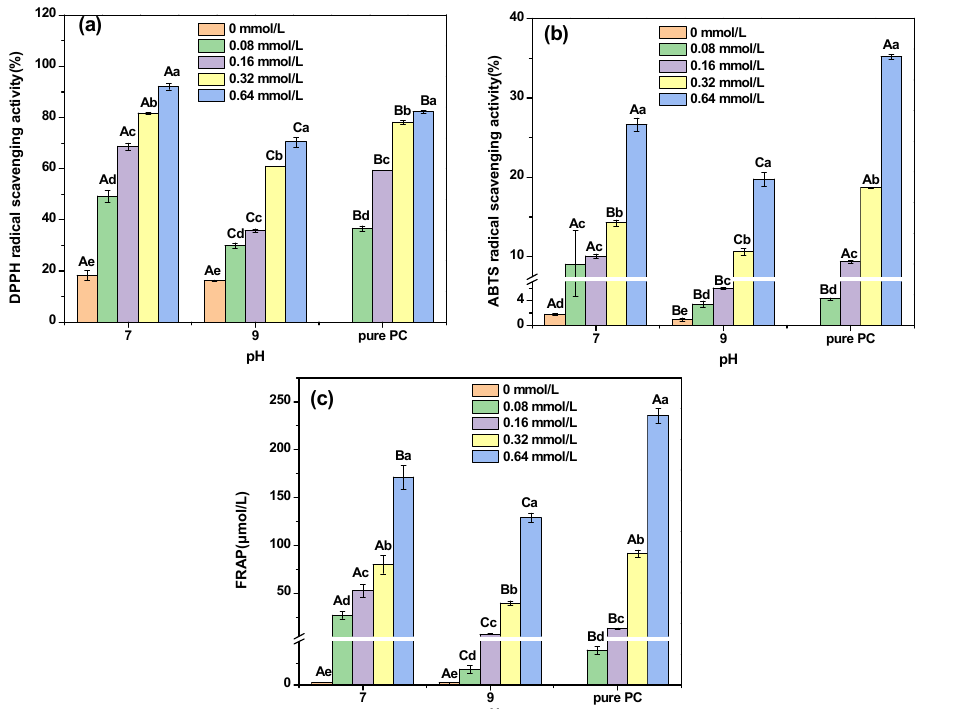
Figure 6. DPPH scavenging ability ( a ), ABTS radical scavenging ability ( b ), and FRAP reducing power ( c ) analysis of decolorized highland barley protein (DHBP)–proanthocyanidin (PC) complexes. a–e mean values with different letters under the same conditions; A–C mean values with different letters under different conditions, indicating a significant difference ( p < 0.05),